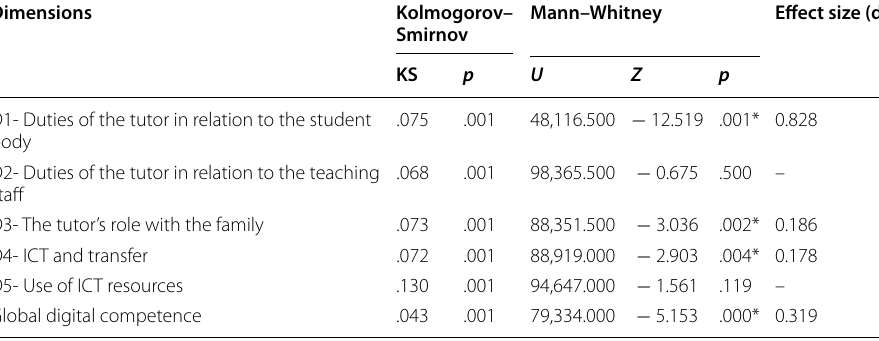
*Significance level at